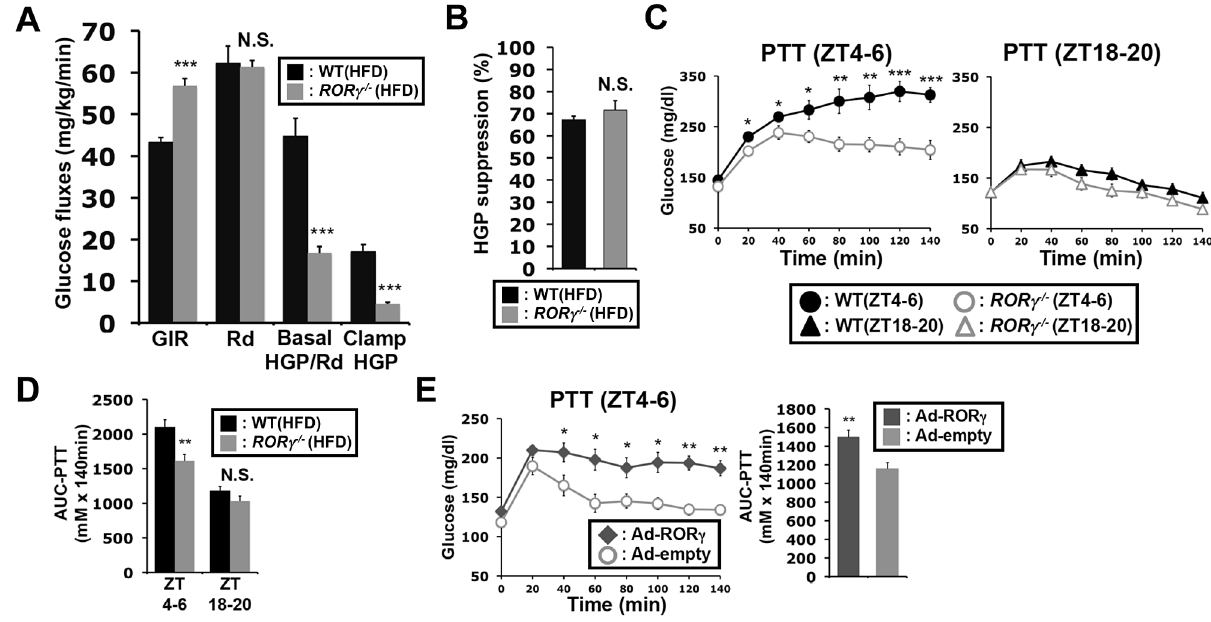
Figure 2. Loss of ROR c leads to reduced hepatic gluconeogenesis at daytime. ( A ) The hyperinsulinemic-euglycemic clamp test was performed during daytime (ZT2–9) in WT(HFD) and ROR c 2 / 2 (HFD) mice and the glucose infusion rate (GIR), whole-body glucose disappearance (Rd), basal endogenous hepatic glucose production (Basal HGP), and endogenous hepatic glucose production during the clamp (Clamp HGP) were determined. ( B ) Suppression rate of hepatic glucose production by insulin in WT(HFD) and ROR c 2 / 2 (HFD) mice. ( C ) PTT was examined at ZT4–6 and ZT18–20 in WT(HFD) and ROR c 2 / 2 (HFD) mice (n=8) as indicated. ( D ) Comparison of AUC for PTT by one way ANOVA. AUC for PTT was also evaluated by 2-way ANOVA: Time period, P=0.0001; Genotype, P=0.0009 (not shown). ( E ) PTT was examined at ZT4–6 in ROR c 2 / 2 (HFD) mice injected with either empty or ROR c -containing adenovirus injection (n=6). Data represent mean 6 SEM, * P , 0.05, ** P , 0.01, *** P , 0.001 by ANOVA.